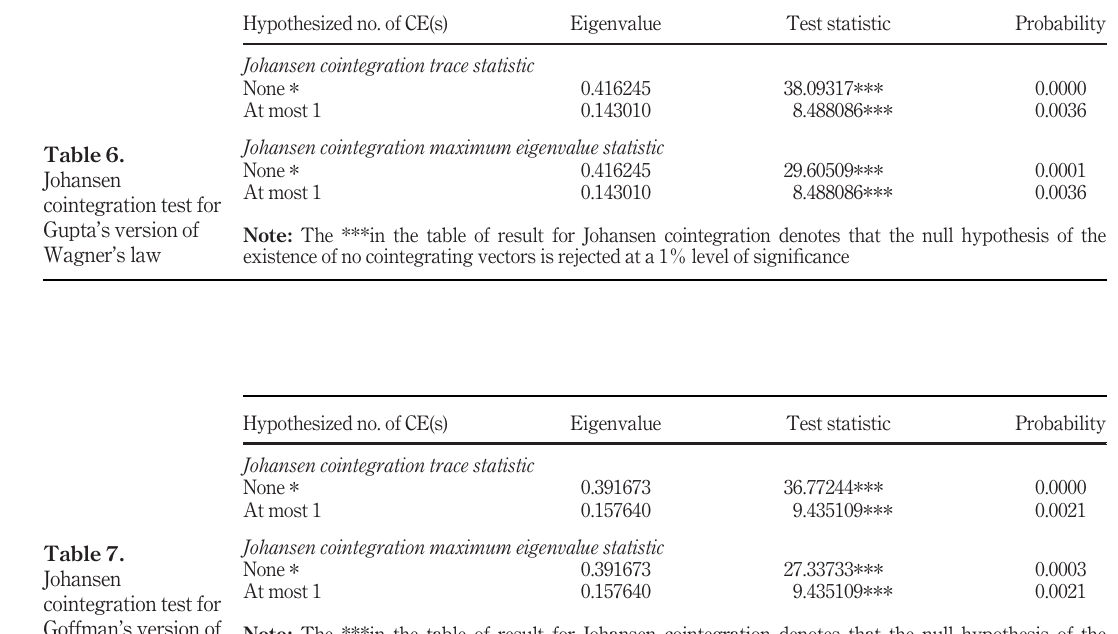
Table 7. Johansen cointegration test for Goffman ’ s version of Wagner ’ s